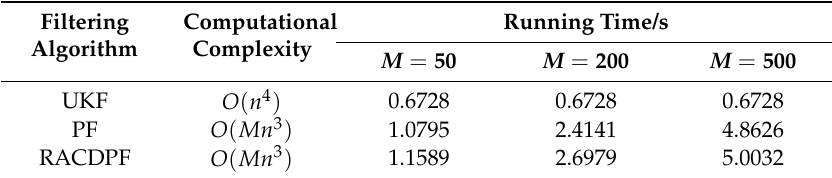
Table 7. Real-time performance of the nonlinear filtering